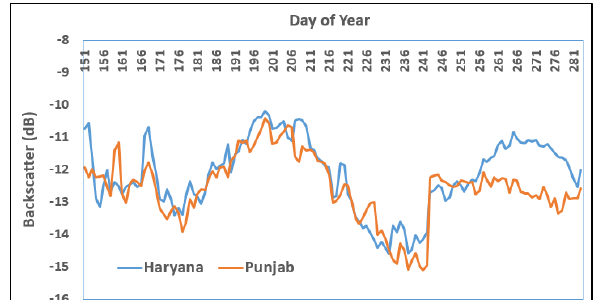
Figure 2: Temporal behaviour of backscatter for Rice